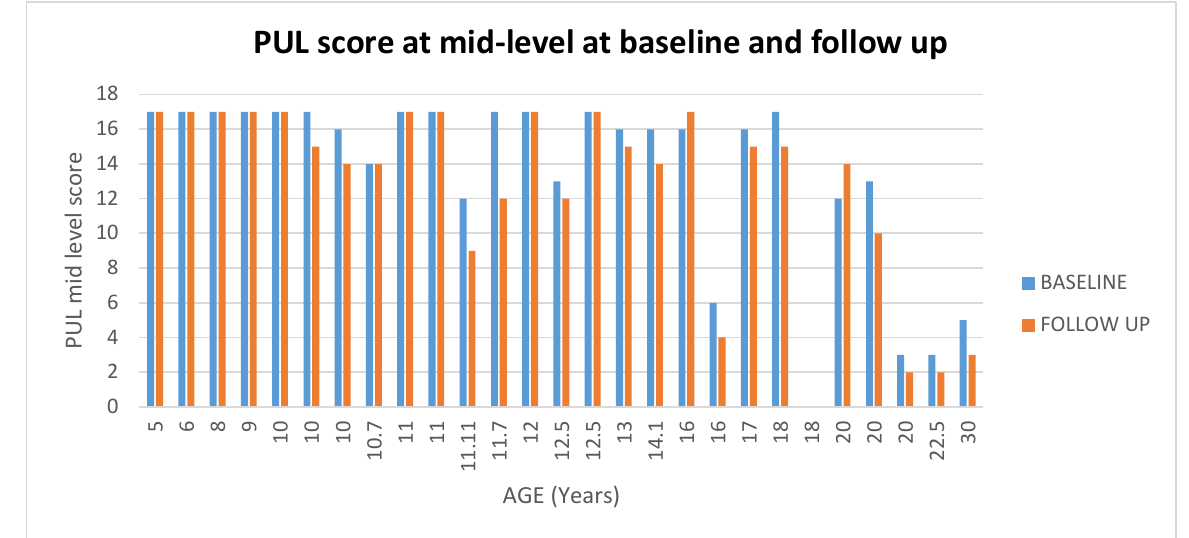
Figure 9. showed scores in PUL at Mid-level at baseline and at follow up according to the age.